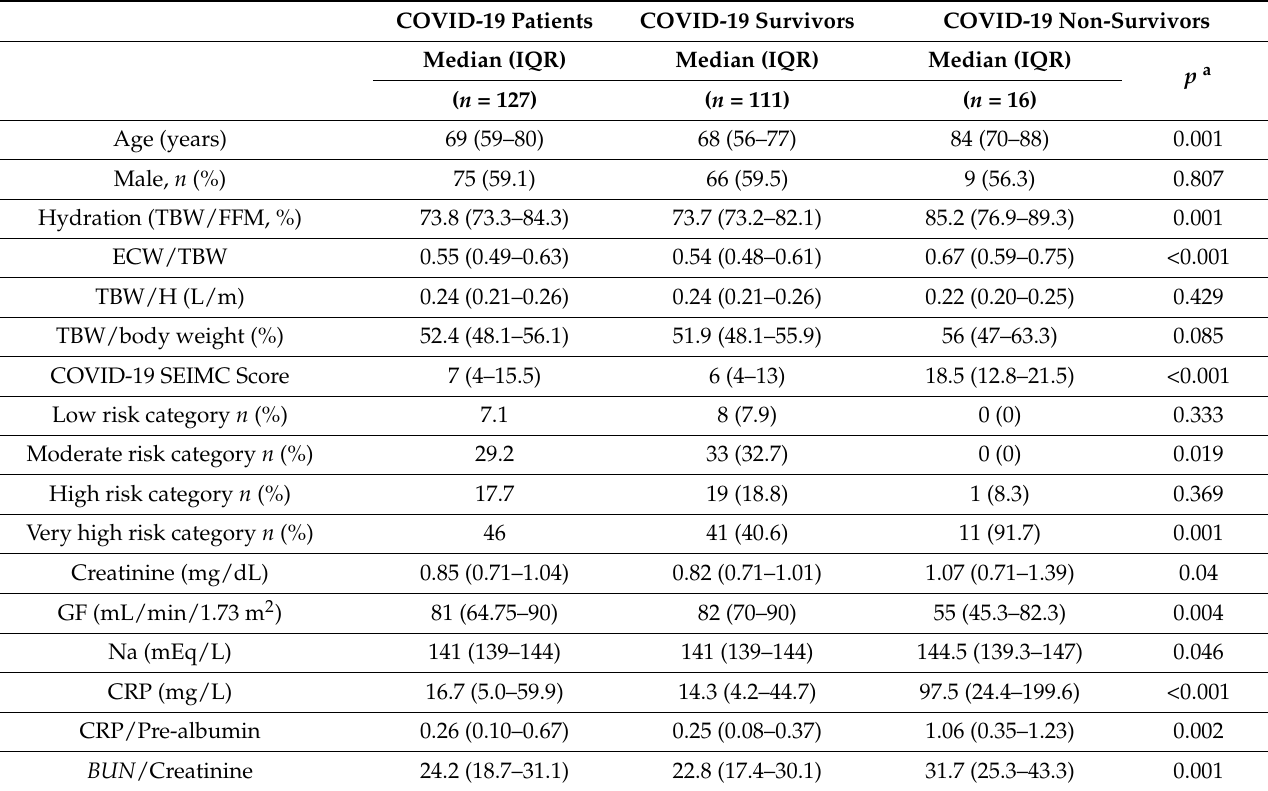
Table 1. Physical characteristics and biochemical measurements of COVID-19 patients related to survival and